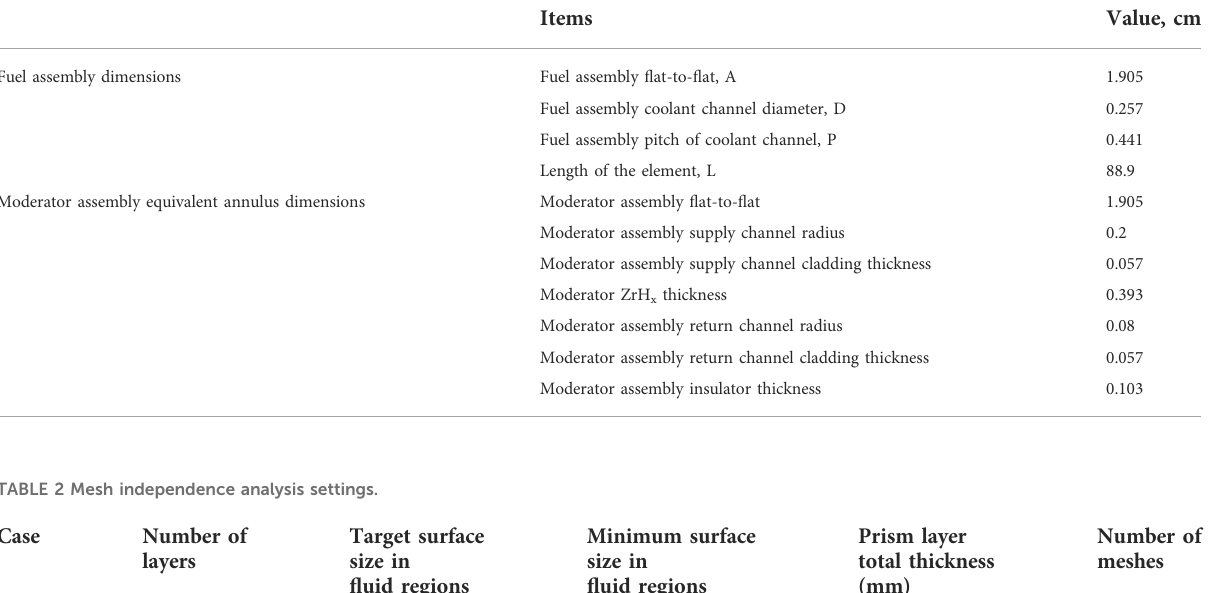
TABLE 1 Assembly geometric dimensions.